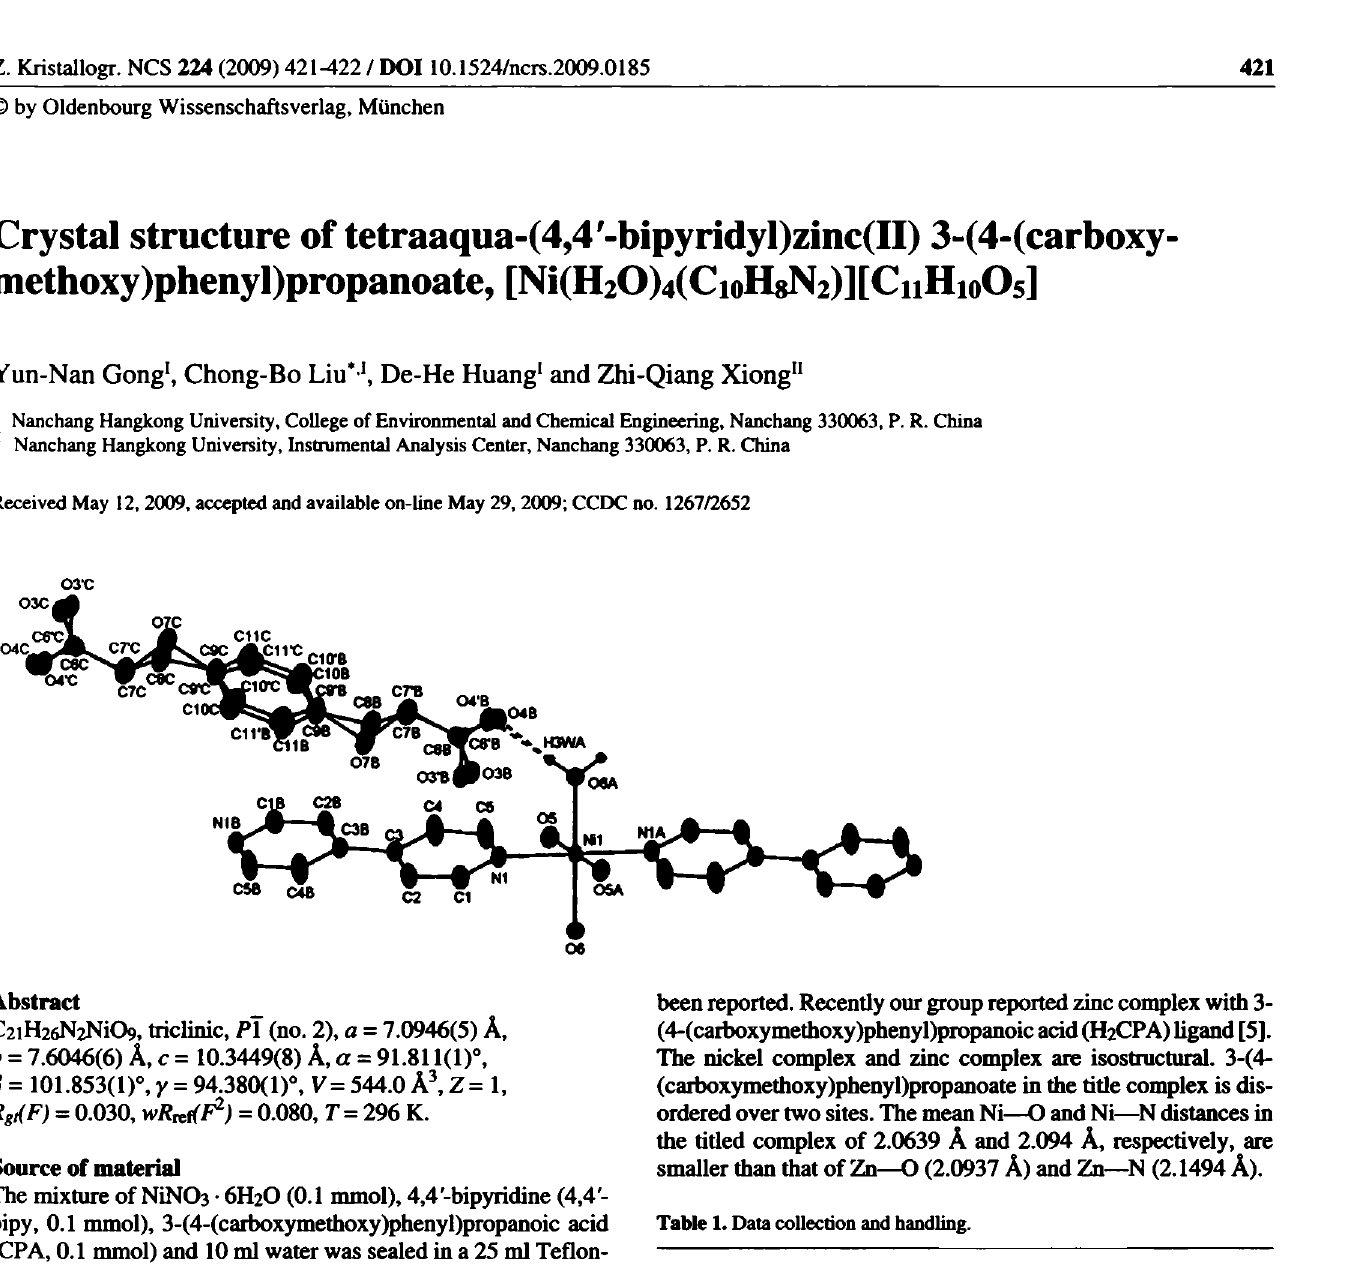
Table 1. Data collection and handling.